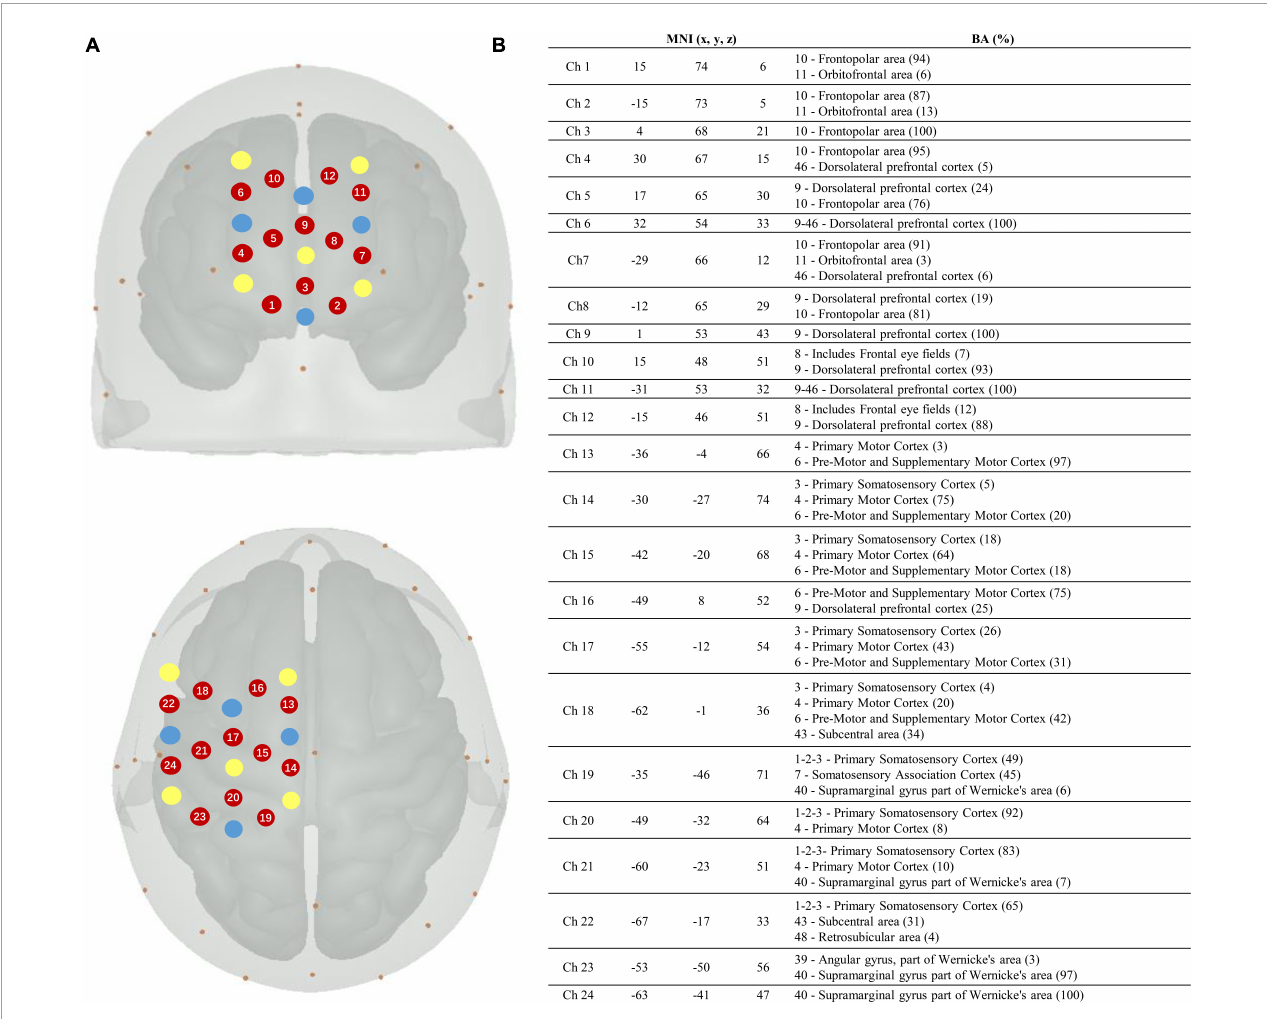
FIGURE2 Localization of the fNIRS optodes, channels, MNI coordinates, and Brodmann correspondences. (A) Yellow, transmitters; blue, detectors; and red, channels. (B) Montreal Neurological Institute (MNI) coordinates for each channel ( n = 24) with x, y, and z coordinates. The Brodmann area correspondences (number, name, and %) were extracted from the NIRS-SPM toolbox on the